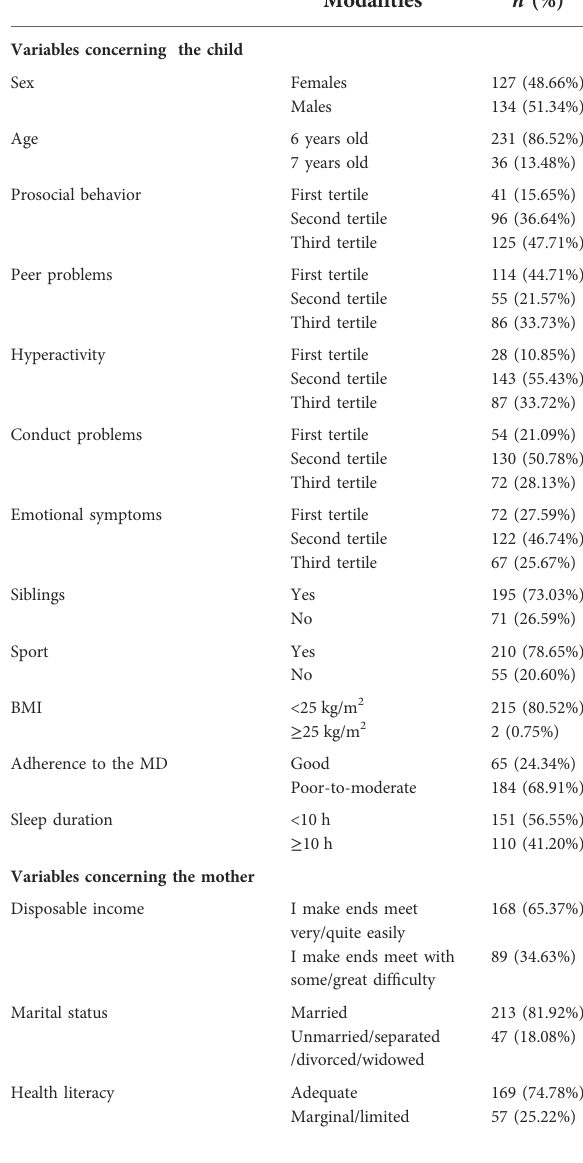
TABLE 1 Characteristics of the study